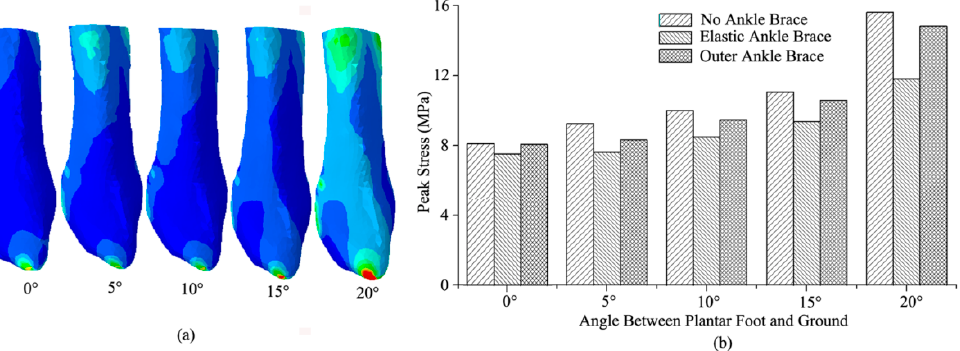
Figure 7. Peak stress and stress distribution of the fibula when the foot landing on 0–20 ◦ incline: ( a ) the stress-distribution tendency; ( b ) peak stress under non-, elastic-, and external-ankle-brace